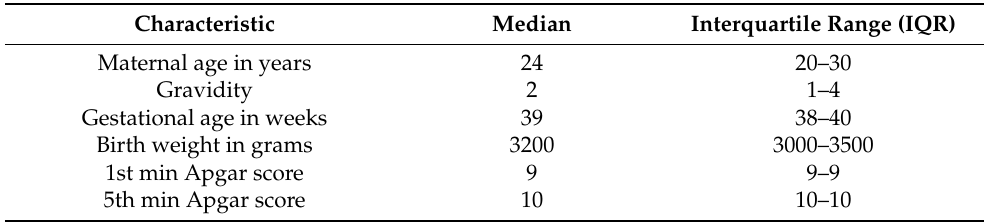
Table 1. Characteristics of